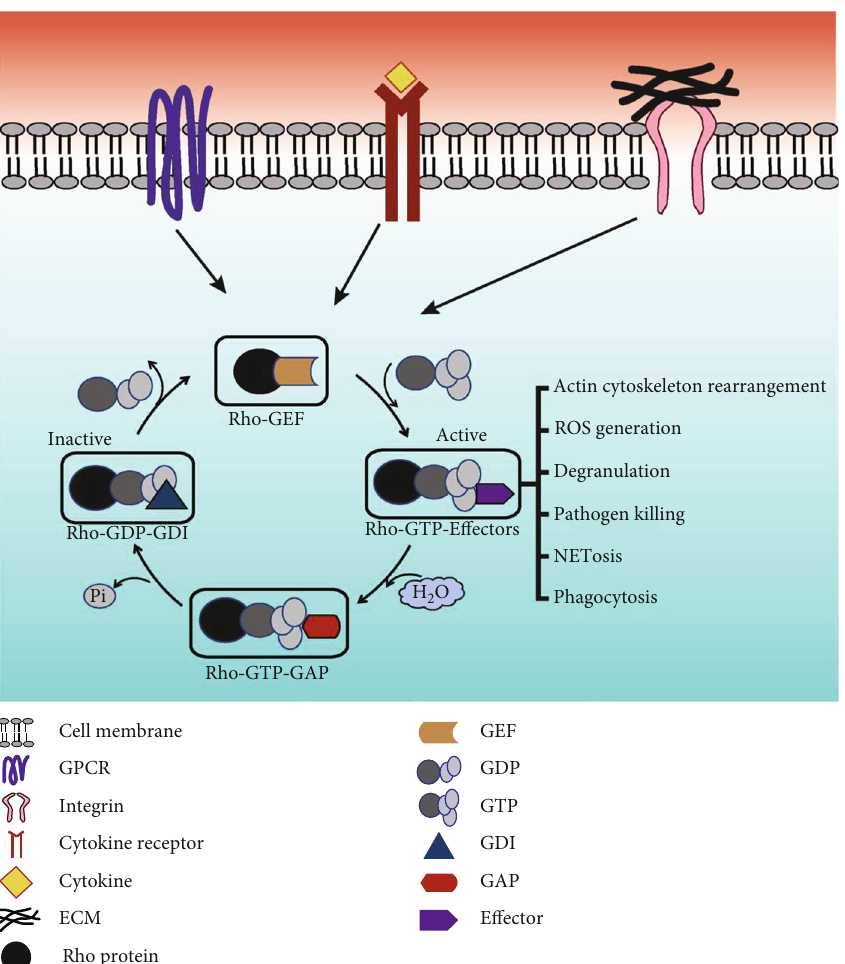
Figure 1: Overview of activation and regulation of Rho proteins during in fl ammation. Extracellular signals mediated through cell surface receptors such as GPCR, integrins, and cytokine receptors lead to the activation of RhoGTPases, resulting in various e ff ector functions of in fl ammatory immune cells. The precise regulation of Rho proteins is performed by mostly three regulatory proteins, namely, GEFs, GAPs, and GDIs. Rho proteins primarily active in GTP-bound form become nonfunctional in GDP-bound form. Guanine Nucleotide Exchange Factors (GEFs) activate the Rho proteins by exchanging GDP for GTP, and in GTP-activated form, GTPases bind to di ff erent e ff ectors and perform a downstream cellular function such as actin cytoskeleton rearrangement, cell cycle progression, and gene expression. GTPase-Activating Proteins (GAPs) enhance the intrinsic GTP hydrolysis of Rho-GTPase by releasing inorganic phosphate (Pi), thereby inactivating GTPases. The third regulatory protein is guanine nucleotide dissociation inhibitors (GDIs), which keep Rho proteins in GDP-bound form and prevent the localization of GTPases from the cytosol to the plasma membrane, and protects them from the action of